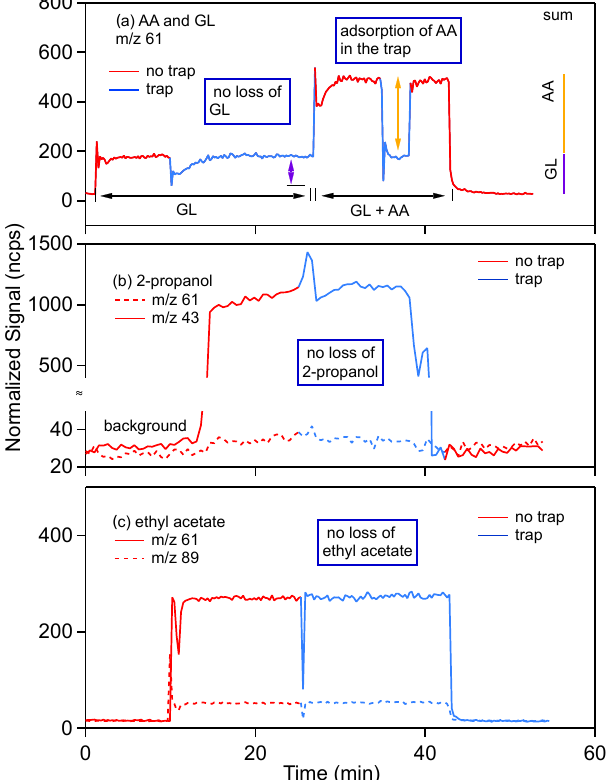
Figure 8. Separation of isobaric species detected at m/z 61 in the laboratory using the acid trap. Shown are (a) AA and glycolalde- hyde (GL), (b) 2-propanol, and (c) ethyl acetate. “No trap” indi- cates periods when the acid trap was bypassed. AA is quantitatively retained by the trap, whereas glycolaldehyde, ethyl acetate, and 2- propanol are unaffected.